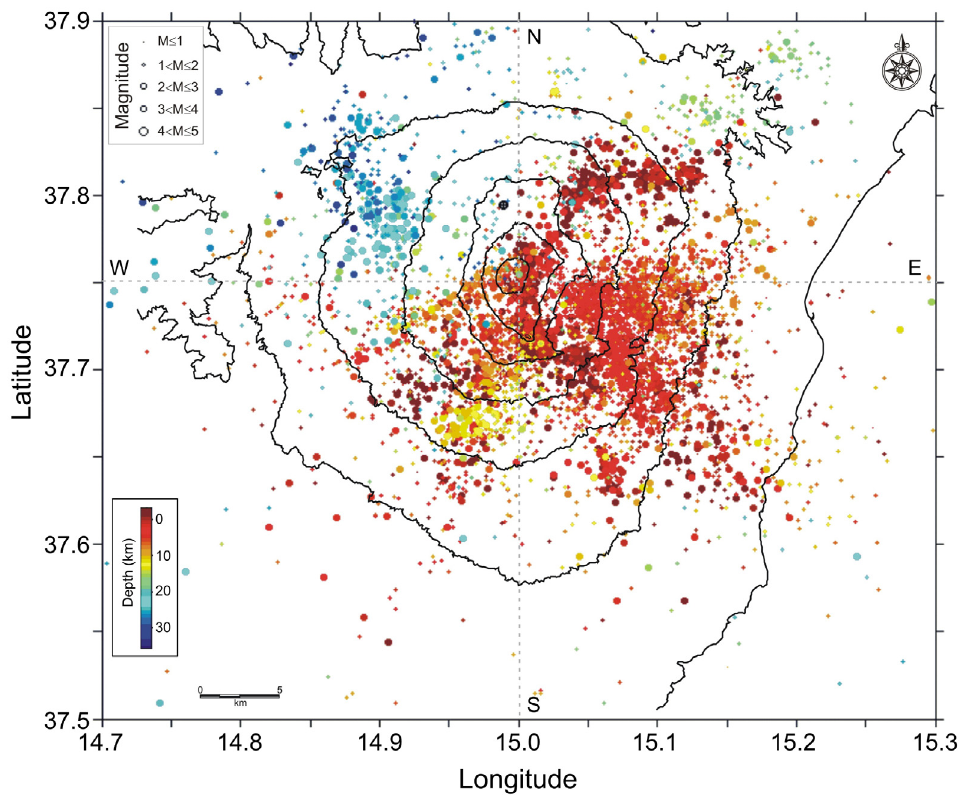
Figure 9. Epicentral map of earthquakes belonging to Mt. Etna seismic catalogue in the period 2000-2010. Circle size indicates magnitude, colors indicate range depth (see inset for details). N-S and E-W indicates the traces of the cross-sections (see Figure